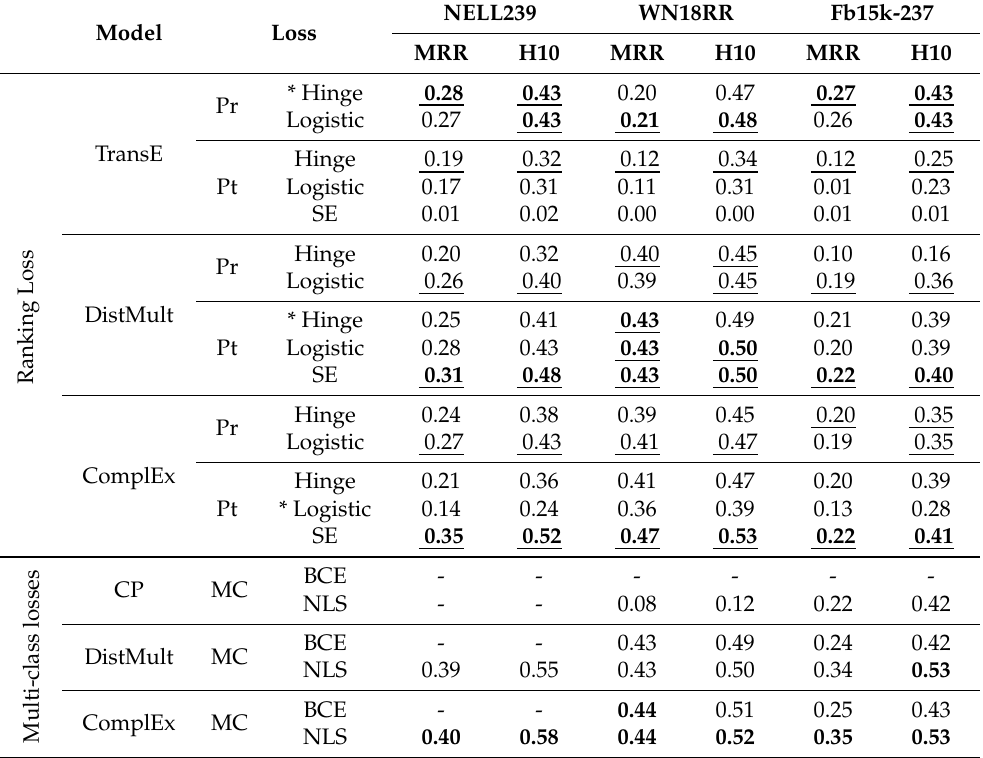
Table 2. Link prediction results for KGE models with di ff erent loss functions on standard benchmark- ing datasets. The abbreviations MC , Pr , Pt stand for multi-class, pairwise and pointwise, respectively. The * mark is used to denote the model’s original loss function as first proposed by the authors. In the ranking losses, the best results are computed per model and highlighted using bold font, and underlined values represent the best result in each respective loss approach.